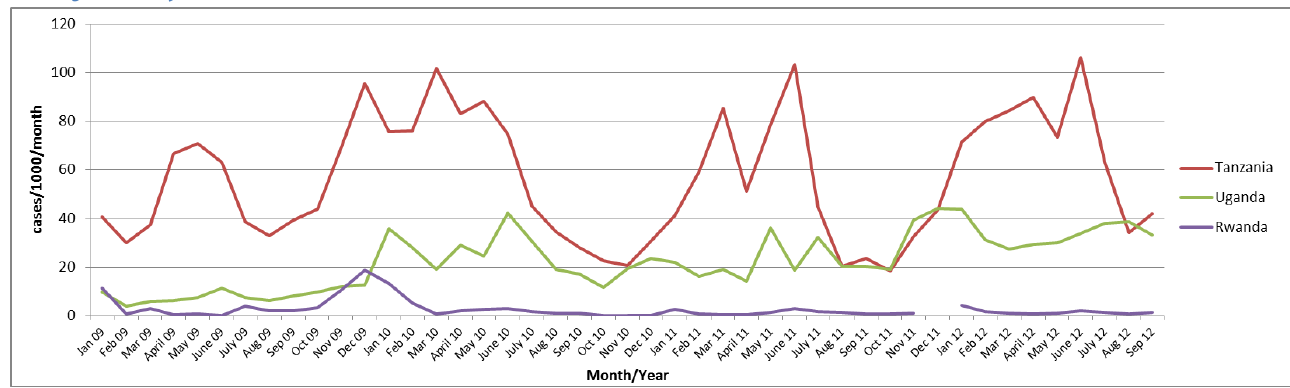
Figure 8: Incidence rates of confirmed malaria cases in refugee camps in Rwanda, Tanzania, Uganda, and by month, 2009 – 2012